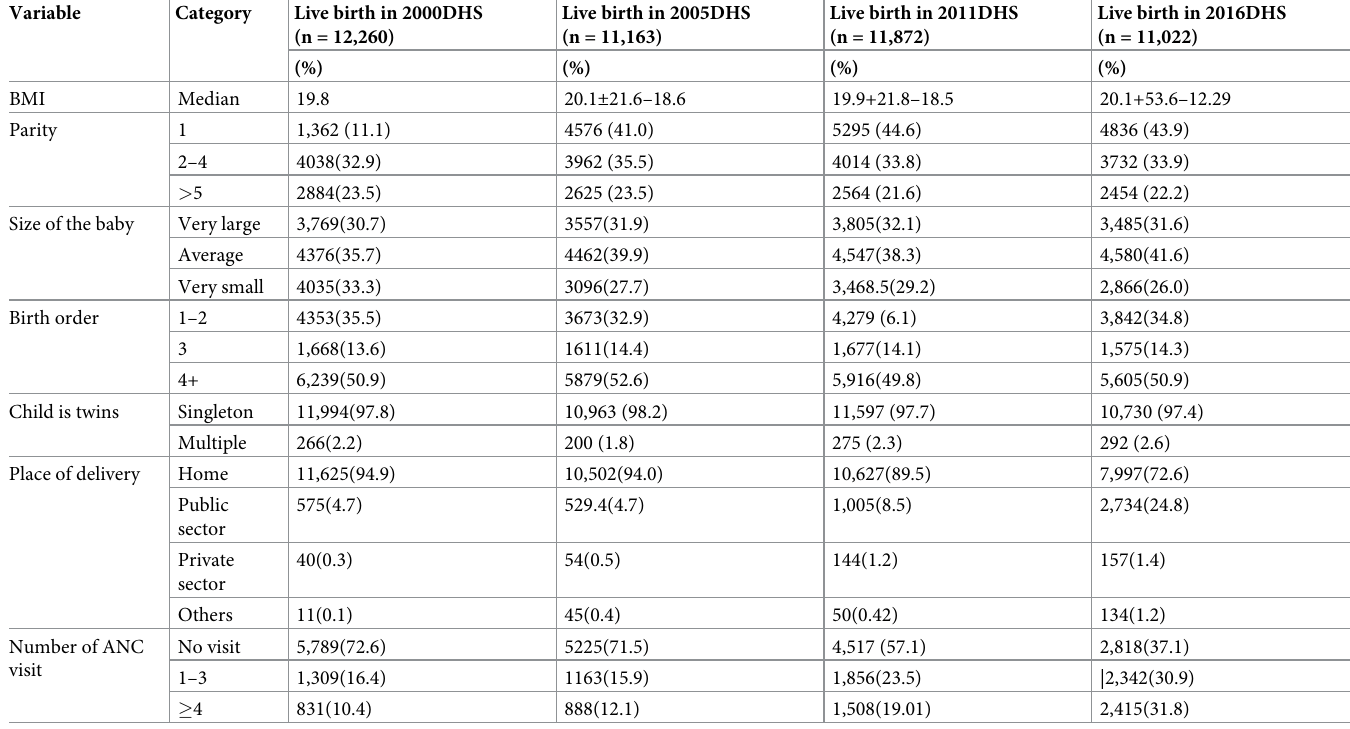
Table 2. Child and maternal, characteristics and health service usage finding from 2000 to 2016